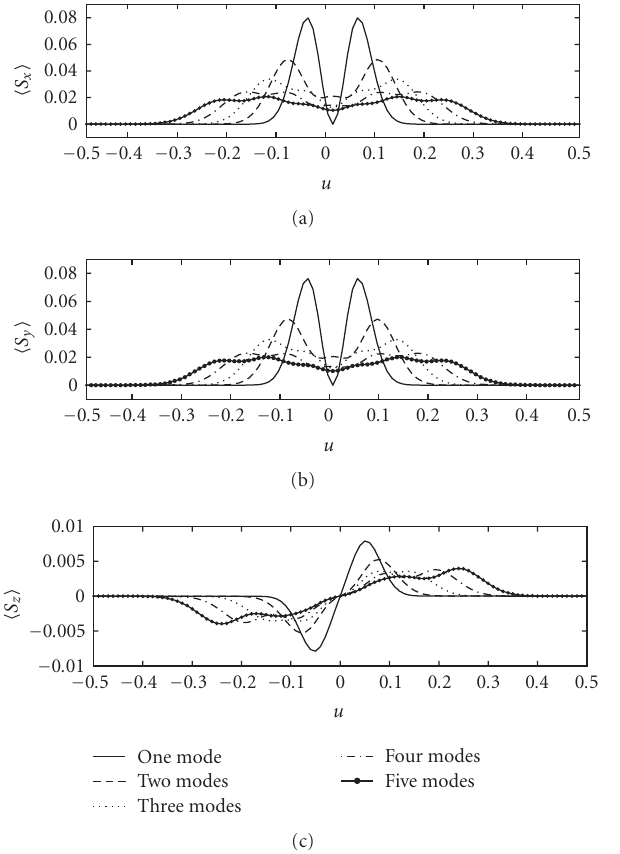
Figure 2: The spin polarization components (cid:2) S i (cid:3) ( i = x , y , z ) as a function of the transverse position u . The Rashba strength α R = 0 . 5 × 10 − 11 eVm and (cid:2) S z (cid:3) indicates the out-of-plane spin accumulation.